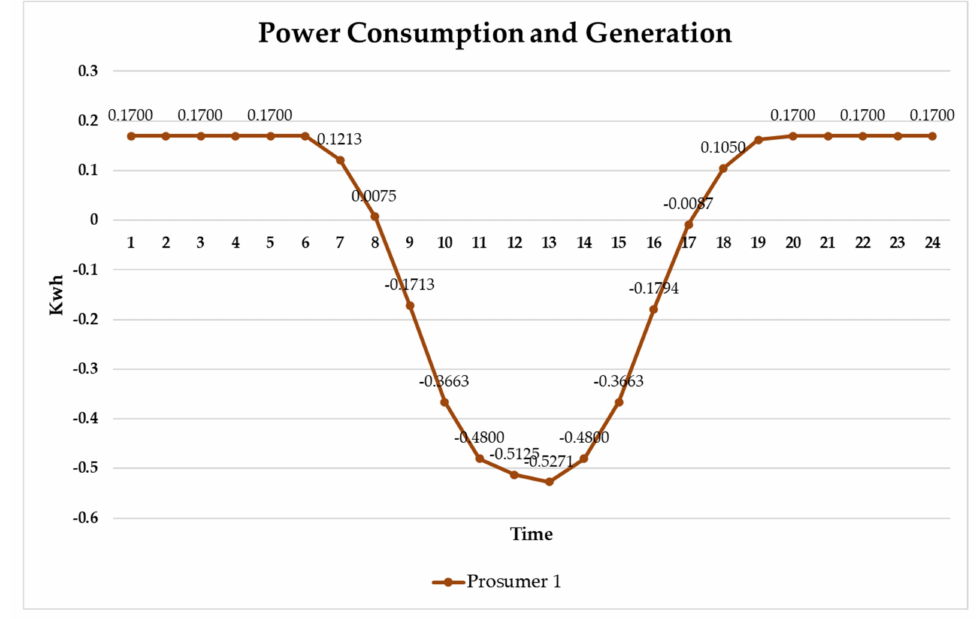
Figure 9. Real-time energy production and consumption status for Prosumer 1 (Rn =